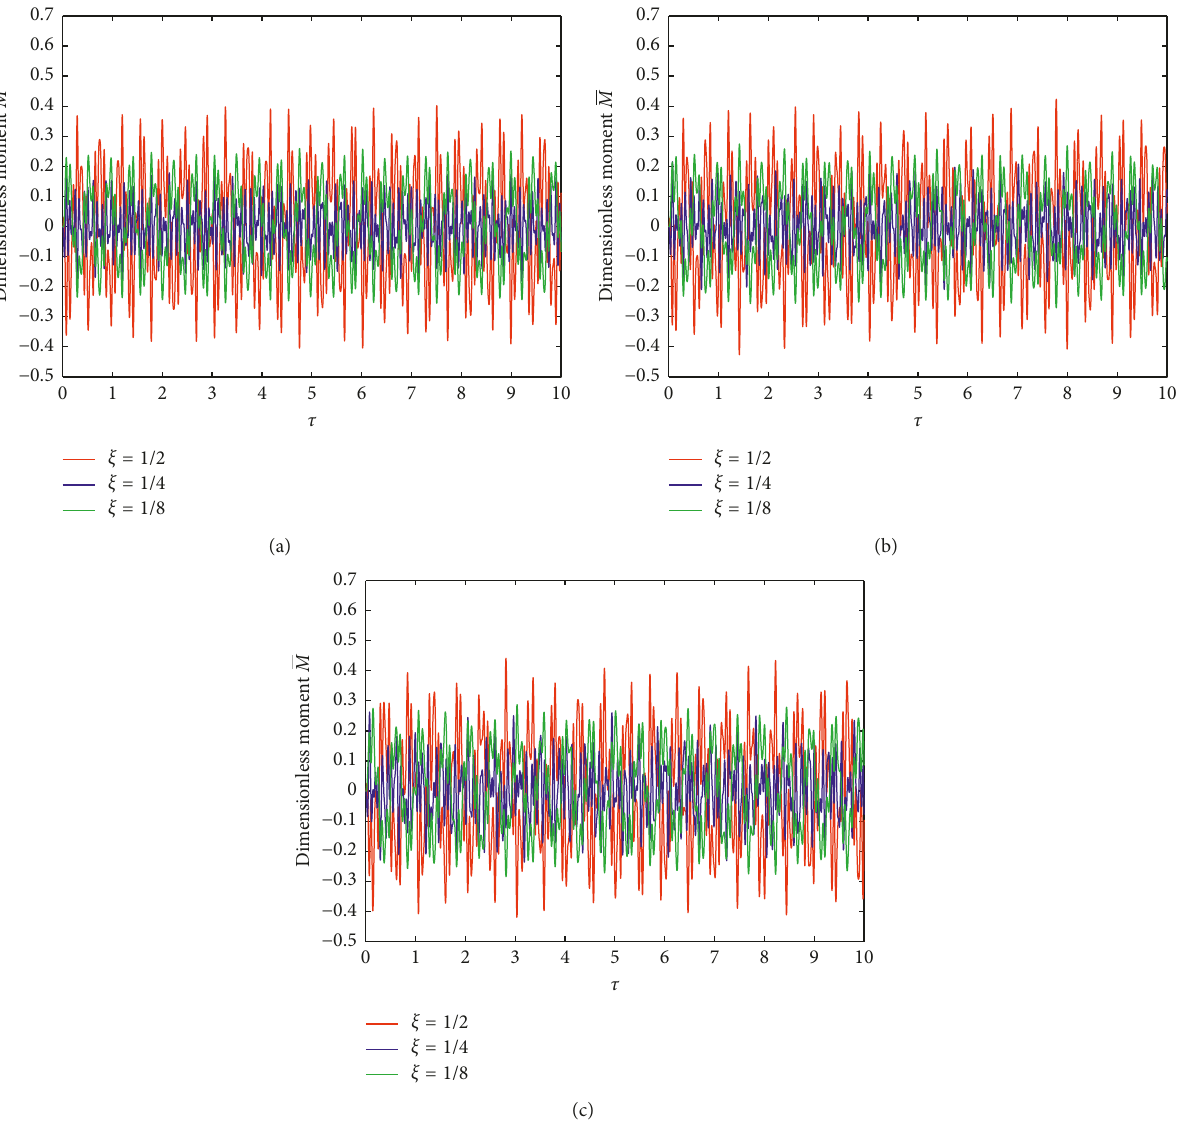
Figure 15: History curves of bending moment response for the clamped-pinned pipe at different locations and under different fluid velocities: (a) u � 0; (b) u � 1; (c) u � 2.